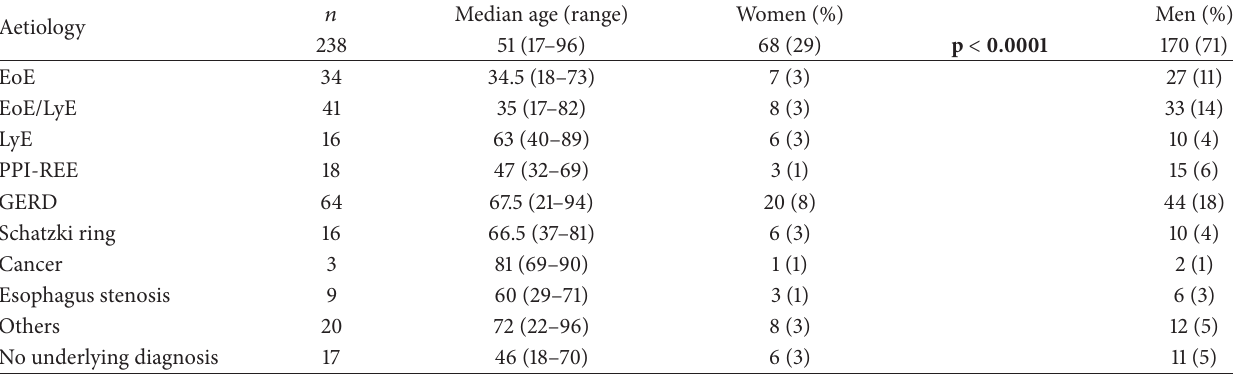
Table 2: Characteristics of esophageal food impaction by age and gender.